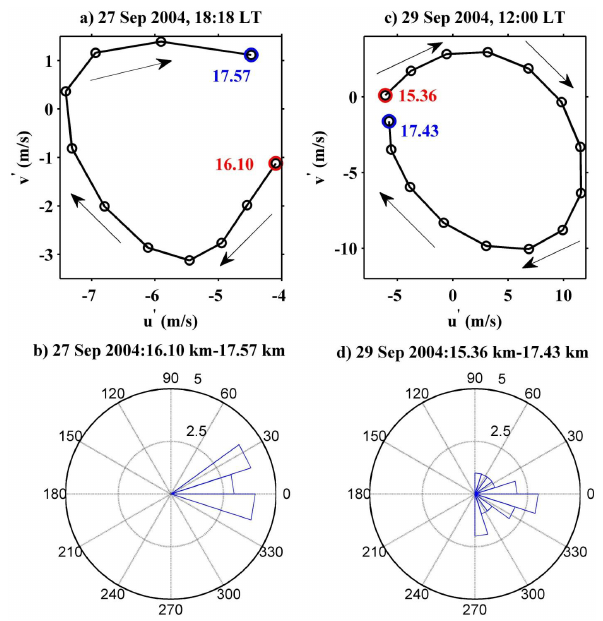
Fig. 8. Same as Fig. 6 for the lower stratospheric region (15–22km). Figure 8. Same as Figure 6 for the lower stratospheric region (15-22 km). 727